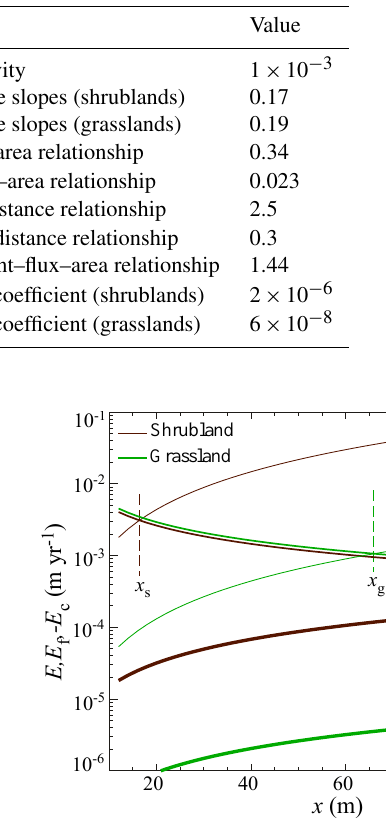
Figure 10. Plots of the total erosion rate, E , the fluvial/slope-wash erosion rate, E f , and the colluvial deposition rate, − E c , as a func- tion of distance along flow lines from divides, x . The values of x s and x g (where E = E f + E c ) are also